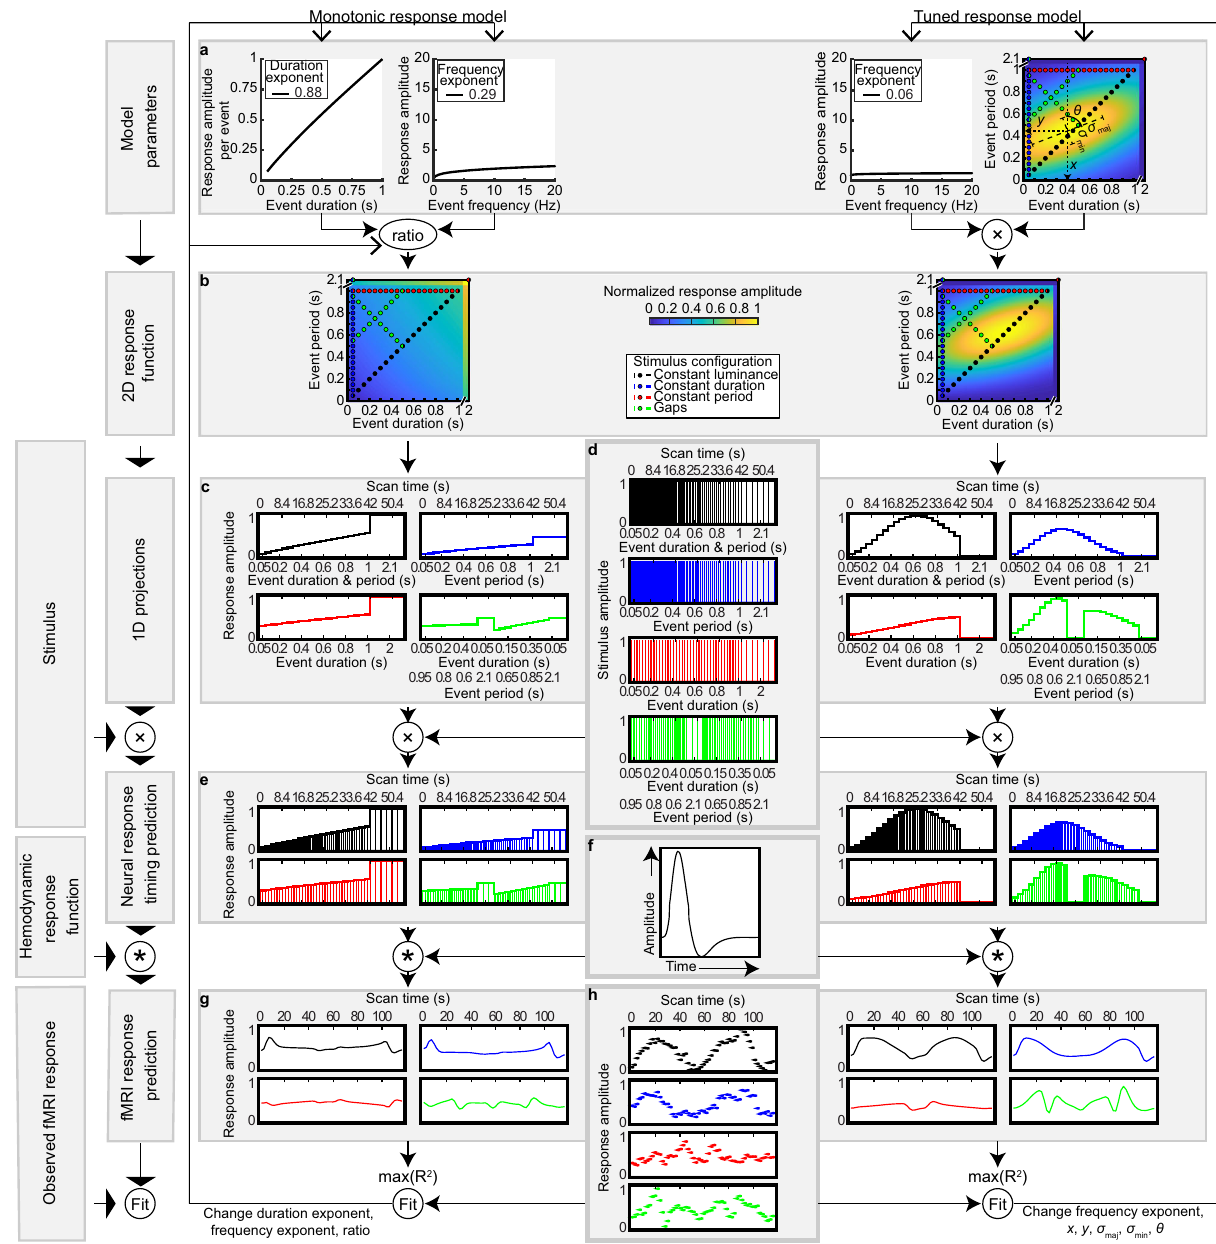
Fig. 1 Monotonic and tuned response model fi tting procedures. a Monotonic response model (left) and tuned response model (right). In each case, a compressive exponent parameter captures a non-linear scaling with increases in event duration (left) or frequency (middle left and middle right). The monotonic response predictions for event duration and frequency changes are combined as a weighted sum. b Together, these make a prediction of the per-event response amplitude for every event timing shown in the stimulus (dots). c This gives a prediction of the response amplitudes that would be seen for each stimulus condition for a speci fi c candidate set of response model parameters. d The times of event offsets in each stimulus condition, which vary in frequency. e Combining the per-event response amplitudes predicted by the response models (in c ) and the times of the event offsets (in d ) gives neural response amplitude predictions for each condition, equal to the amount of color under the curve. f The hemodynamic response function. g The neural response amplitude predictions (in e ) are convolved with a hemodynamic response function (in f ) to get the predicted fMRI response time courses. Note here that these predictions are for both ascending and descending sweeps of duration and/or period, while neural response predictions (in c and e ) are for ascending sweeps only. h The recorded fMRI response time course for an example voxel. The monotonic and tuned predictions were compared to the recording from each voxel. The free parameters of both the monotonic and tuned response models were found that maximized the correlation ( R 2 ) between predicted and measured fMRI response time courses. For the monotonic response model these parameters were the compressive exponents on duration and frequency components, and the weighting of these two components (ratio). This ratio is the ratio of the scaling factors for the two components in a general linear model. For the tuned response model, the free parameters were the compressive exponent on event frequency, preferred duration ( x ), preferred period ( y ), response function extent along its major ( σ maj ), and minor ( σ min ) axes, and major axis orientation ( θ ).